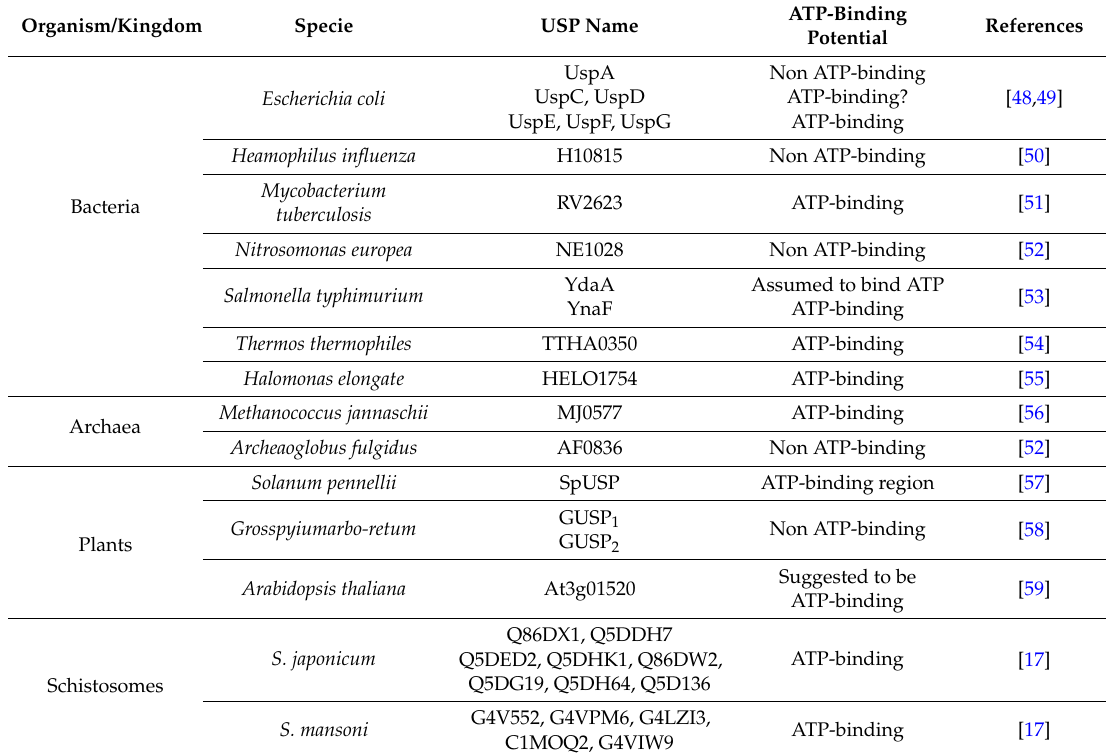
Table 1. Universal stress proteins (USPs) found in different living